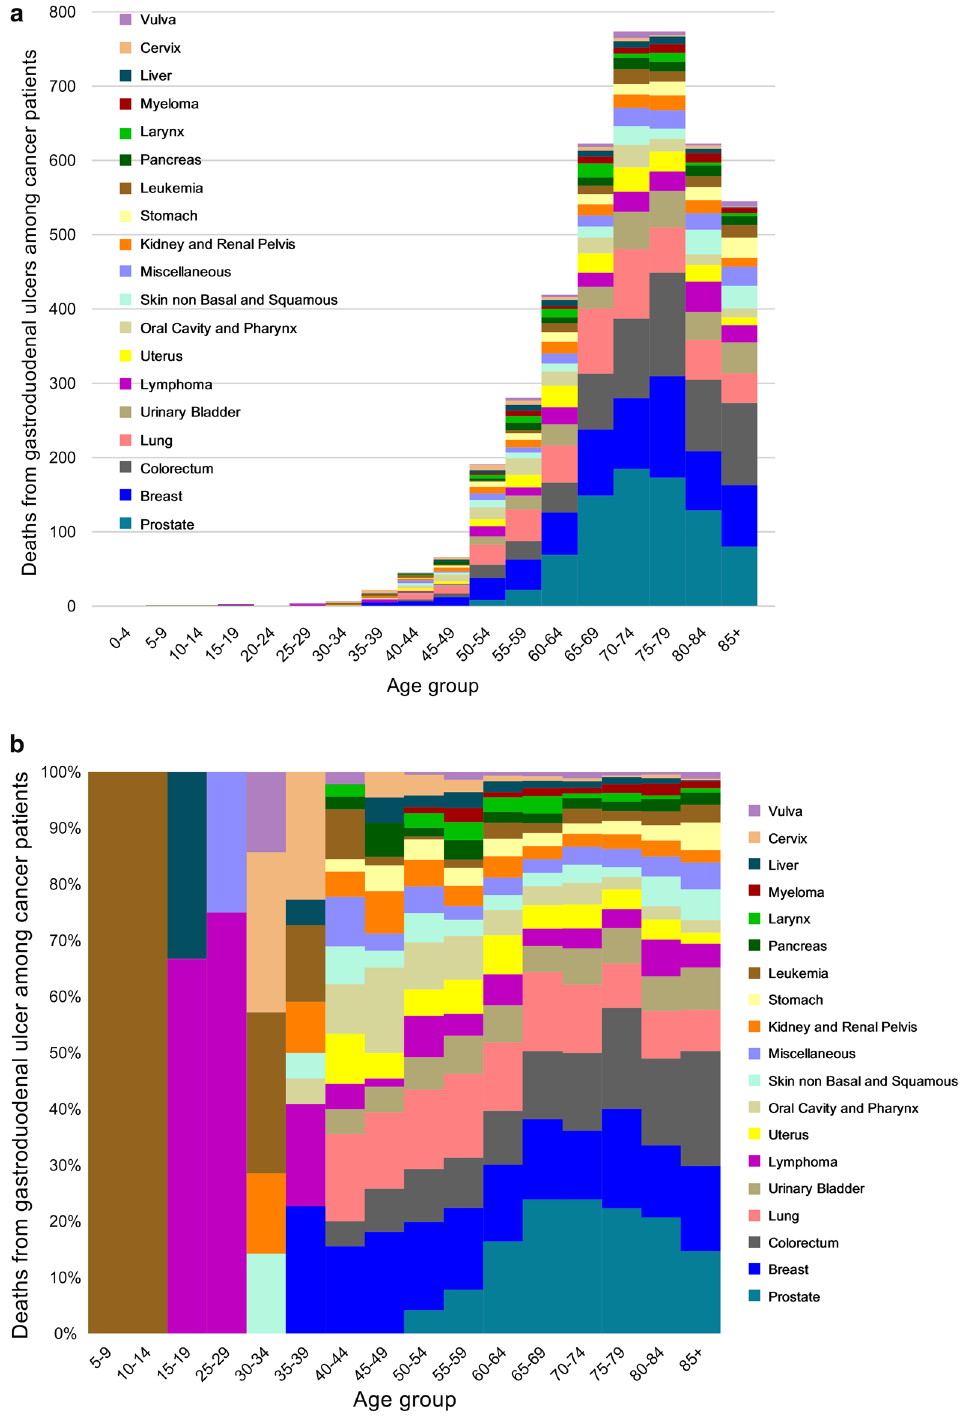
Figure 2. Fatal peptic ulcers among cancer patients as a function of cancer site and age at diagnosis. The colors depict the disease sites. ( a ) The y-axis depicts the absolute number of deaths from peptic ulcers, and the x-axis depicts the age group at the time of diagnosis. Most of the ulcer deaths occurred in patients diagnosed at an older age (i.e., ≥ 50 years) and those with prostate, breast, colorectum, and lung cancer. These 19 cancer sites were chosen because they represent the sites with the most deaths from peptic ulcers. ( b ) The y-axis depicts the relative number of fatal ulcers compared with all cancer patients, and the x-axis depicts the age group at the time of diagnosis. For children, adolescents, and young adults (i.e., < 40 years), the plurality of peptic ulcer deaths was observed in those with leukemia and lymphoma. By contrast, among older adults (i.e., > 40 years), the plurality of fatal ulcers occurred in those with prostate, breast, colorectum, and lung